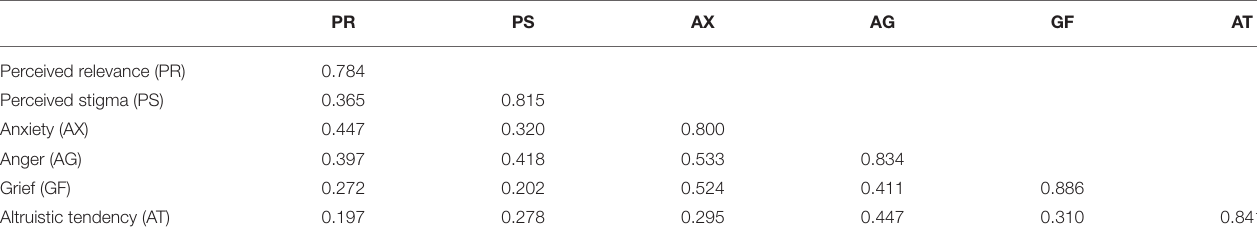
TABLE 3 | Correlation matrix and psychometric properties of key constructs. PR PS